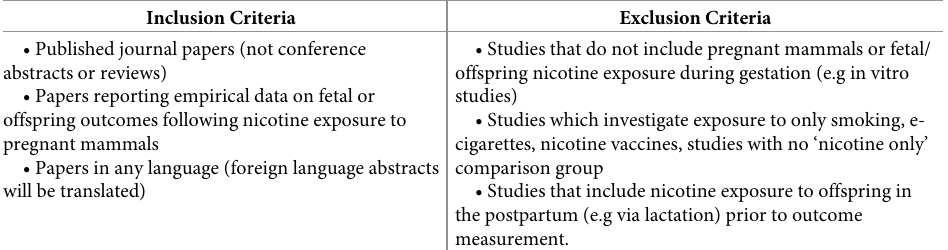
Table 1. Inclusion and exclusion